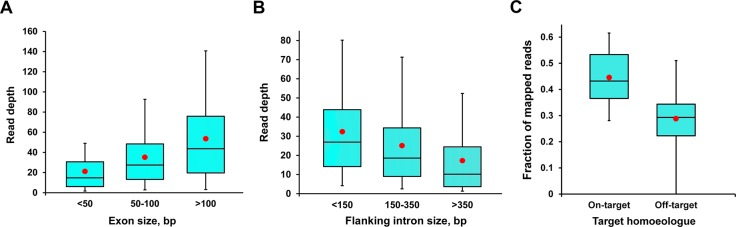
Coverage of exon-capture sequences by exon size, intron size and on-target/off-target homoeologue.(A) Read depth of exon-capture sequences increases with exon size. (B) Read depth of small (<100bp) internal exons (those flanked by two introns) decreases with flanking intron size. (C) The on-target homoeologues have better coverage by the mapped reads than the off-target homoeologues. In the box-and-whisker plots, the top and bottom boundaries of the blue boxes indicate the 75th and 25th centiles, respectively, the whiskers indicate the maxima and minima, the central bars are the median values and the red spots show the means.